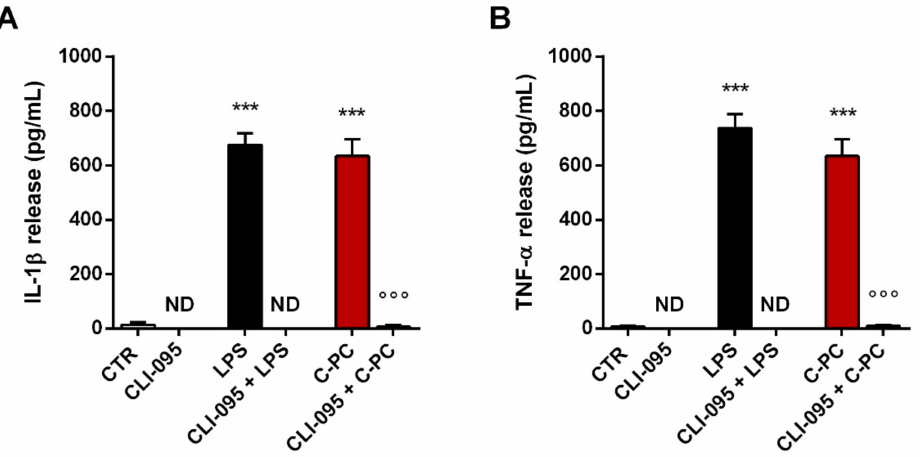
Figure 7. Effect of CLI-095 on cytokine release from cortical microglia. Microglia were cultured overnight in medium containing 10% of serum, which was replaced with serum-free medium before pretreatment with 0.5 µ g/mL CLI-095 for 1 h followed by stimulation with LPS (100 ng/mL) or C-PC (100 µ g/mL) for 16 h. Supernatant were collected and analyzed for IL-1 β ( A ) and TNF- α ( B ) content. Data are means ± SEM ( n = 3 in triplicate). *** p < 0.001 versus control cells and ◦◦◦ p < 0.001